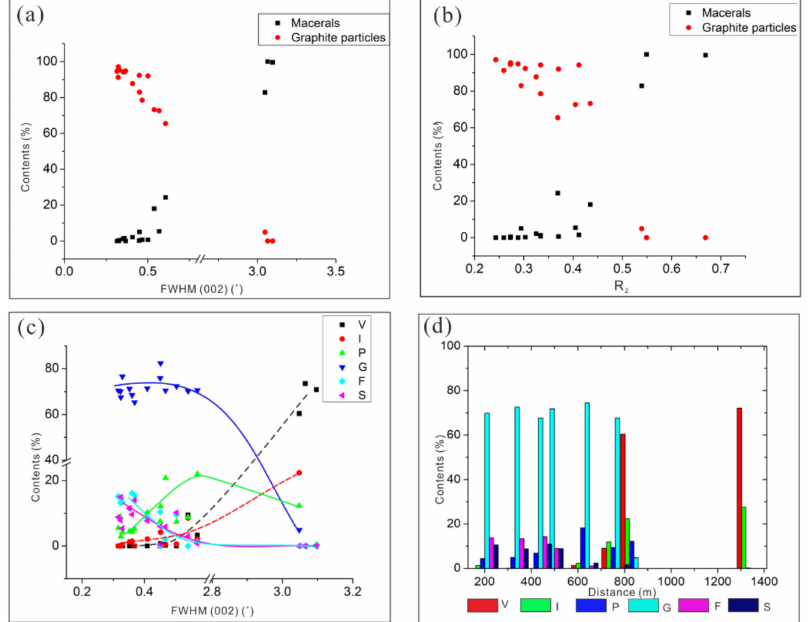
Figure 6. ( a , b ) Content of microstructures (vitrinite (V), inertinite (I), pyrolytic carbons (P), granular particles (G), flakes (F), silk-like graphite (S)) versus FWHM (002) (the full width at half maximum of the (002) peak) and Raman parameter R 2 . ( c ) Correlation of microstructures content with FWHM (002). ( d ) Microstructure content versus distance from the